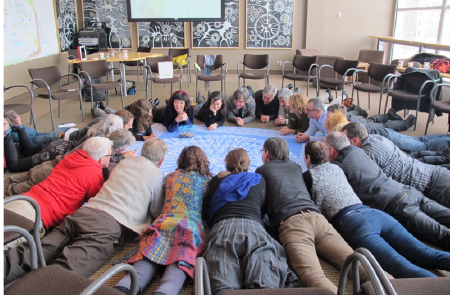
Fig. 2. Experiencing new ideation techniques Forming a new perception of the museum